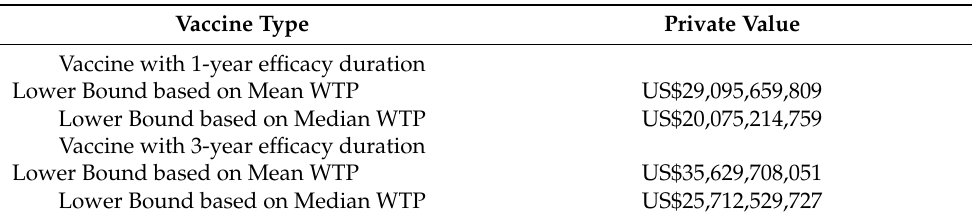
Table 5. Private value of preventing COVID-19 through